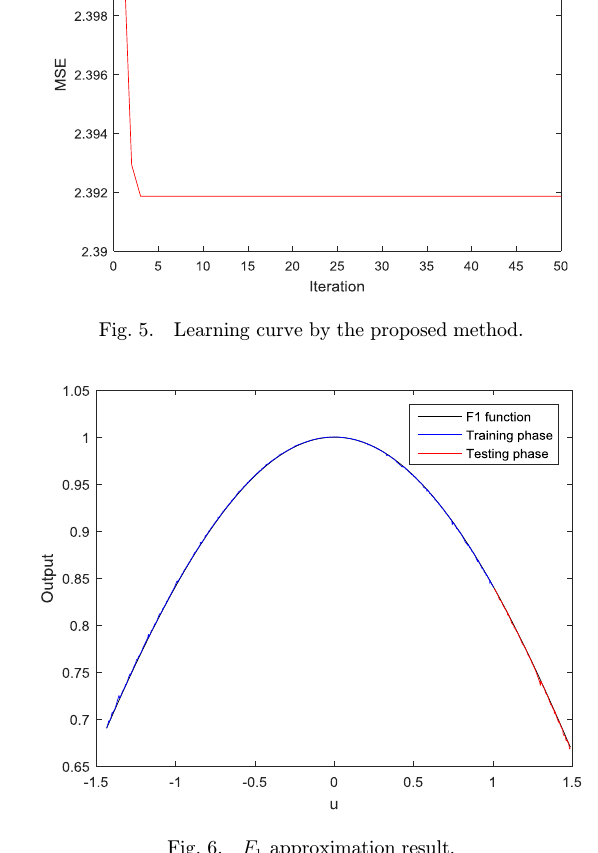
Fig. 6. F 1 approximation result.